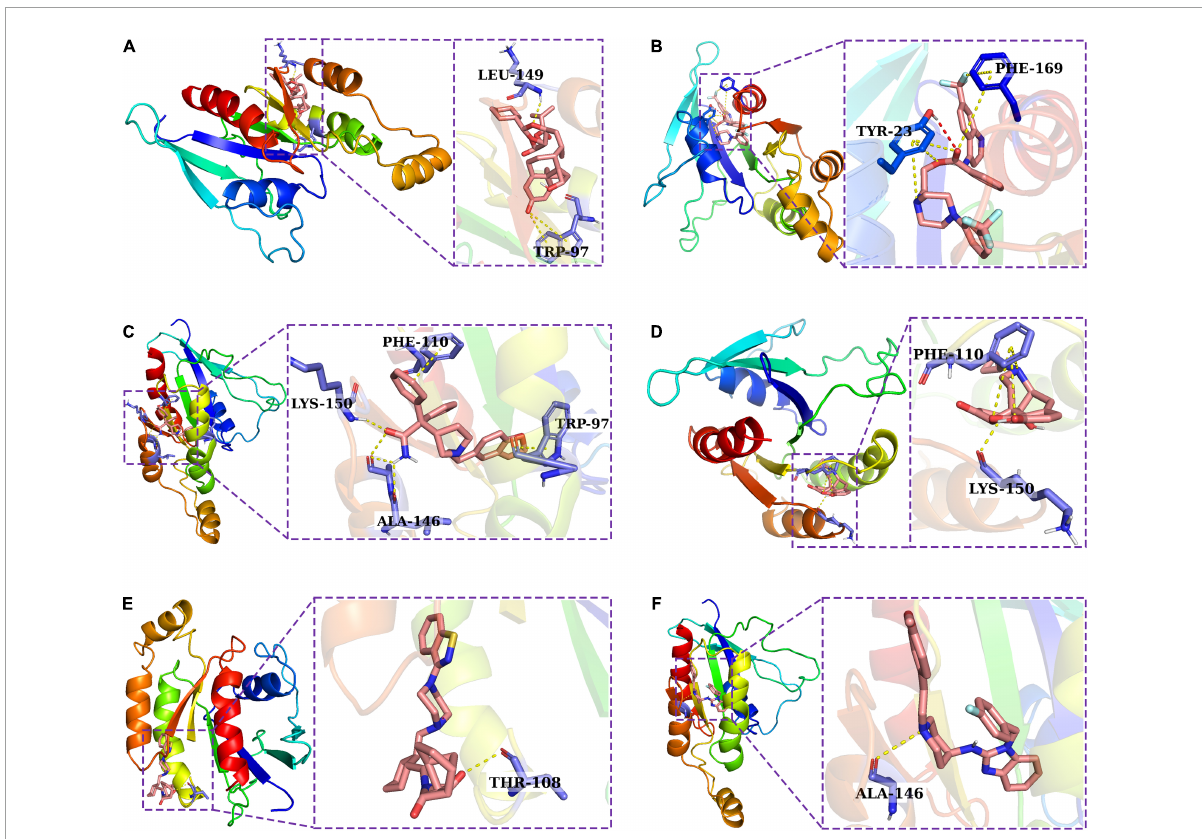
FIGURE8 A molecular docking analysis was used to construct docking models for six potential drugs and their intended targets. Three dimensional (3D) structures showing the binding modes between the predicted binding pocket of CDC42 and ciclesonide (A) , antrafenine (B) , darifenacin (C)